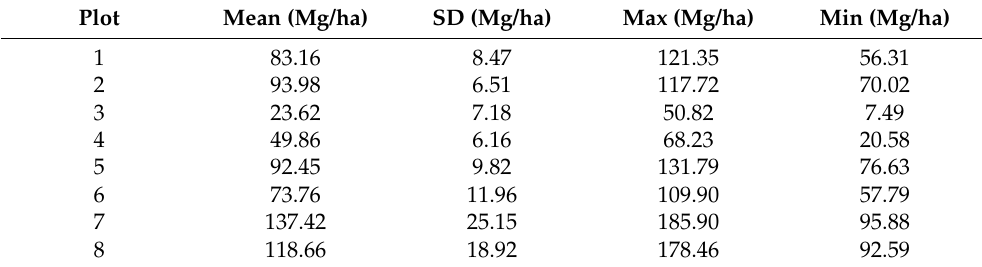
Table 2. Mean, standard deviation (SD), minimum (Min), and maximum (Max) values of individual plot carbon stock density maps produced using the ALS-based methods.